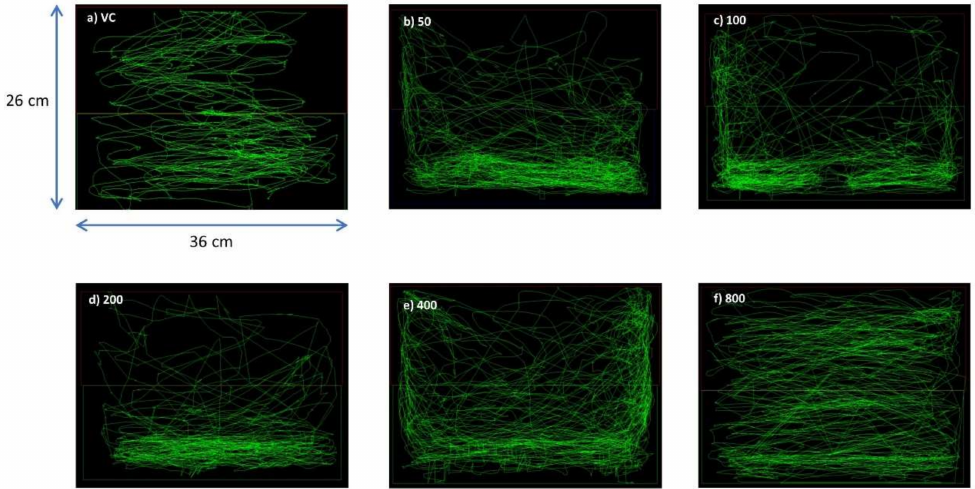
Figure 2. Representative swim paths for the corresponding 6 experimental groups ( n = 8). ( a ) VC (tank water only, i.p.), ( b ) OSLP (50 µ g / kg, i.p.), ( c ) OSLP (100 µ g / kg, i.p.), ( d ) OSLP (200 µ g / kg, i.p.),